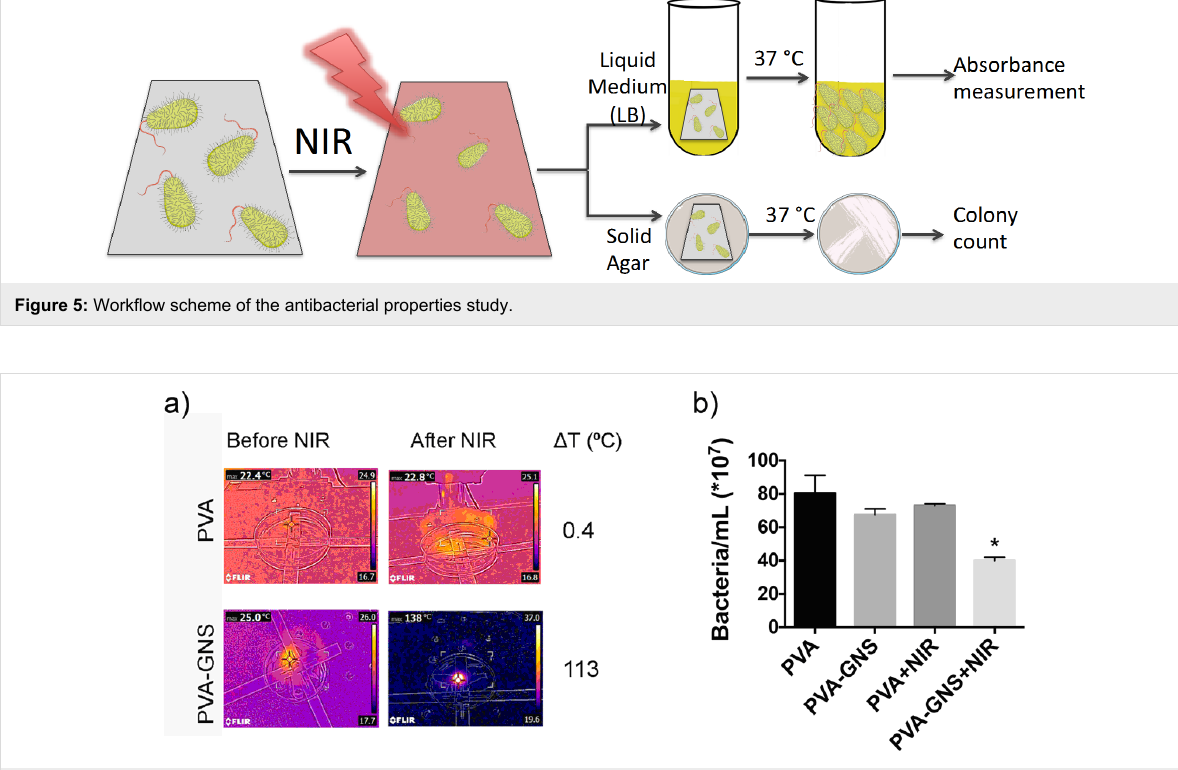
Figure 6: (a) Temperature increase of PVA and PVA-GNS films upon irradiation with a 1064 nm laser, as registered by a thermocamera (laser inten- sity 4 W/cm 2 ). (b) After 5 minutes of laser irradiation (or simply exposure to the air for the control samples) the films were transferred to LB broth and left at 37 °C for cell growth. The number of bacteria per mL was calculated by spectrophotometric measurements at 600 nm (mean + SD). T-test against non-irradiated samples was performed (* p < 0.05).